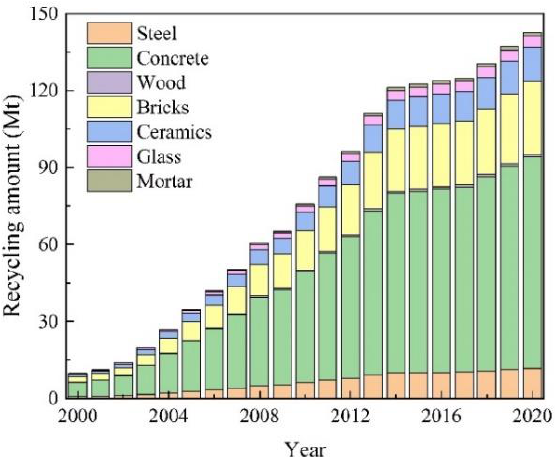
Figure 7. The annual recycling quantity of construction materials in Jiangsu Province from 2000 to 2020.